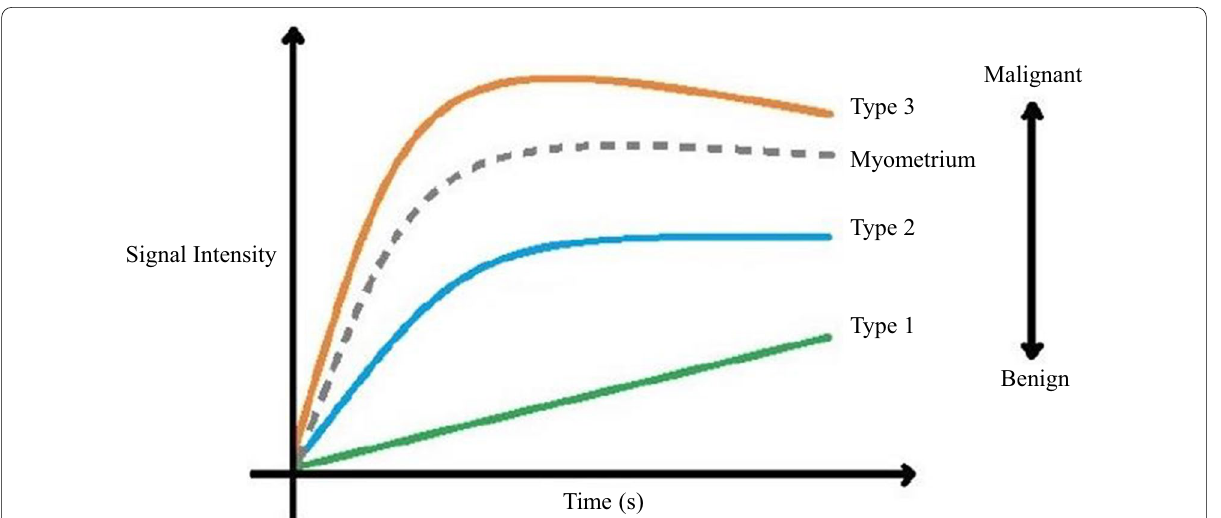
Fig. 10 Time-intensity curves. Time-intensity curves compare the enhancement patterns of the ovarian tumour’s solid aspect with the outer myometrium